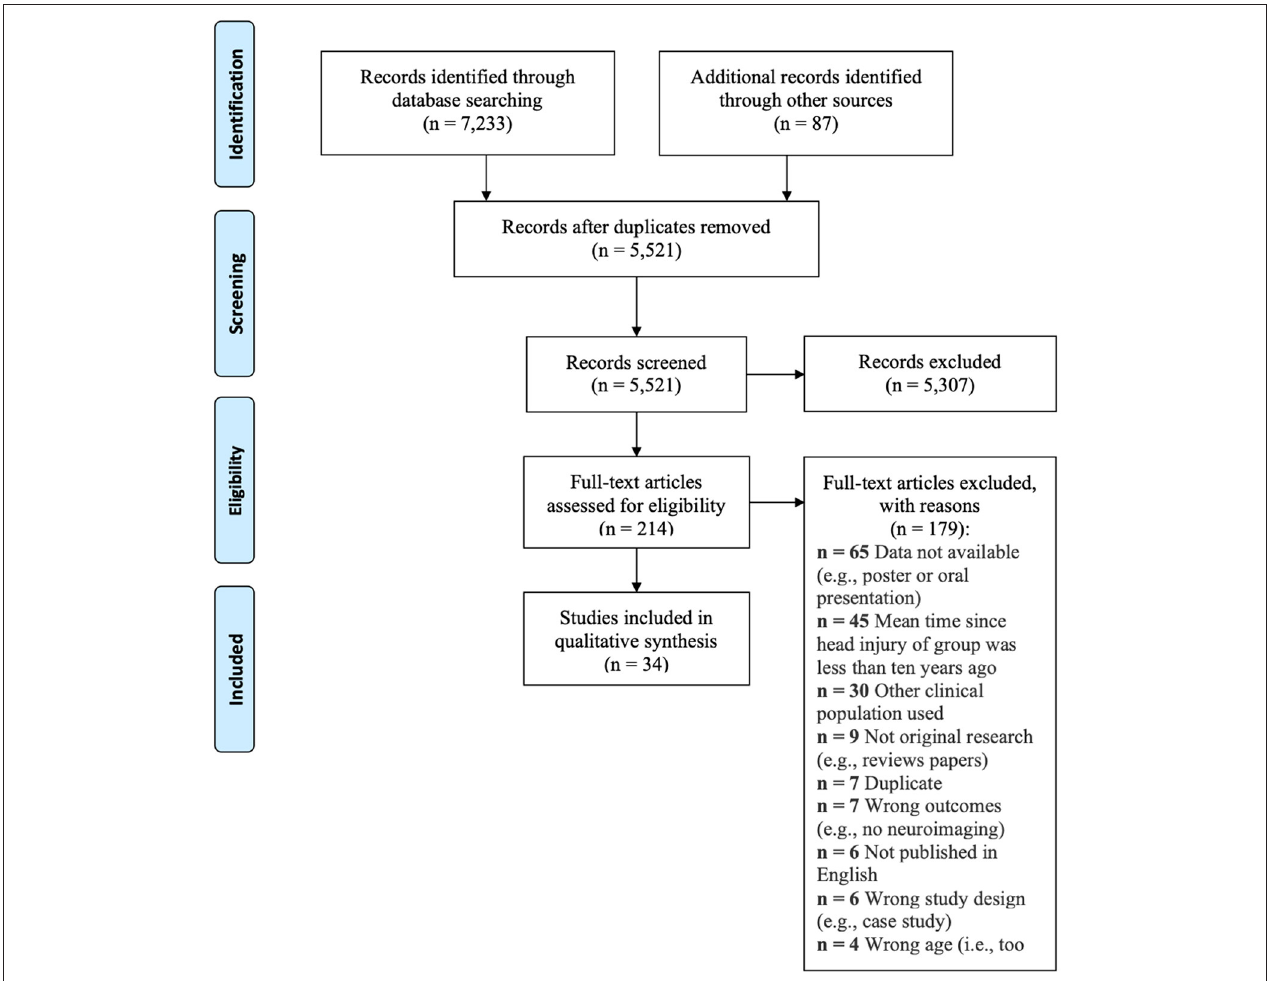
FIGURE 1 | PRISMA flow